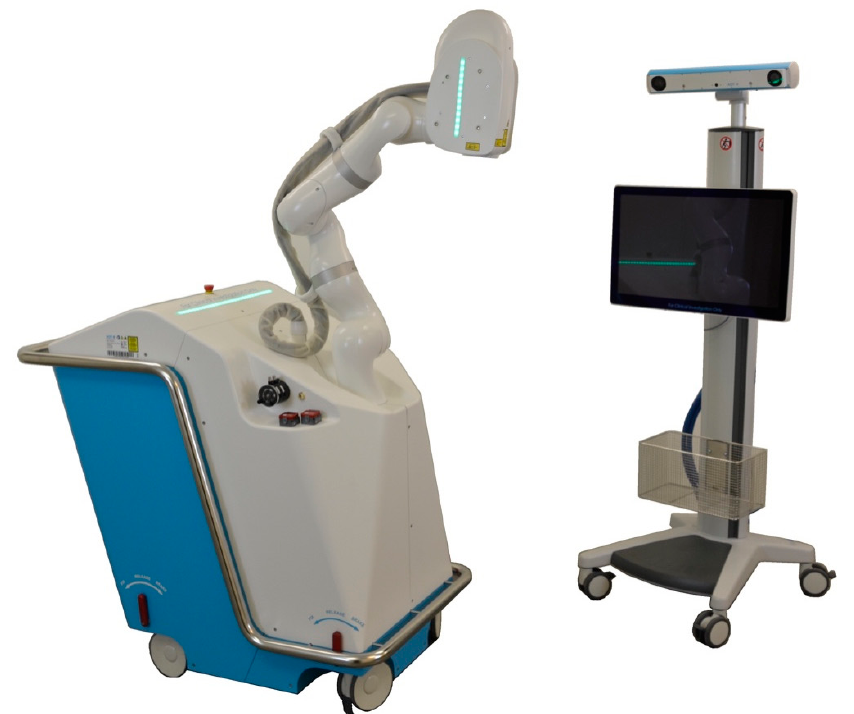
Figure 1. Cold Ablation Robot-guided Laser Osteotome (CARLO ® ) developed by Advanced Osteotomy Tools (AOT AG, Basel, Switzerland) consisting of a laser head mounted on a robotic arm and guided by an optical navigation system.